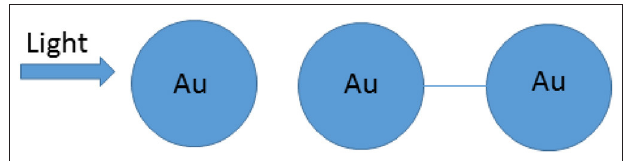
FIGURE 1 | Interaction of light with an isolated nanosphere and coupled nanospheres surrounded by